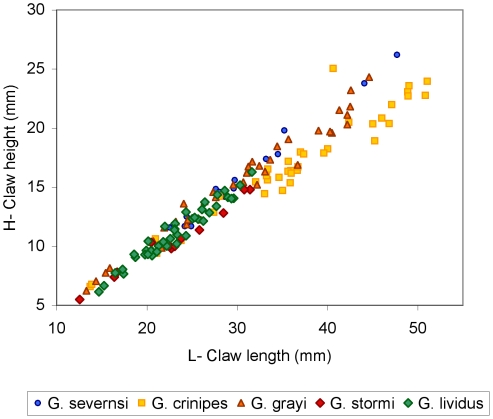
Claw height (H) vs. claw length (L) in mm.